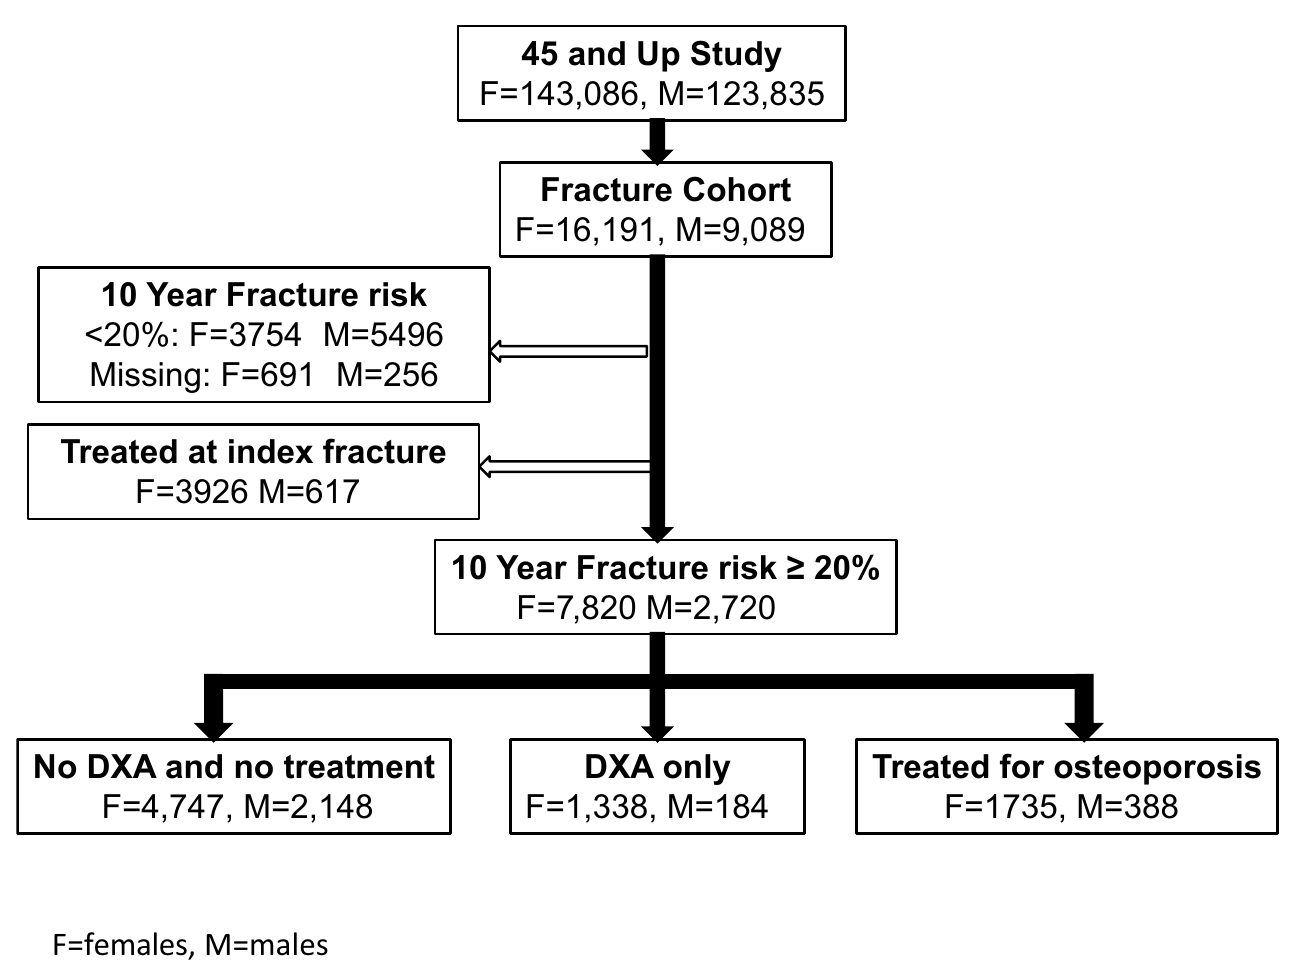
Fig 1. Flow chart and sample